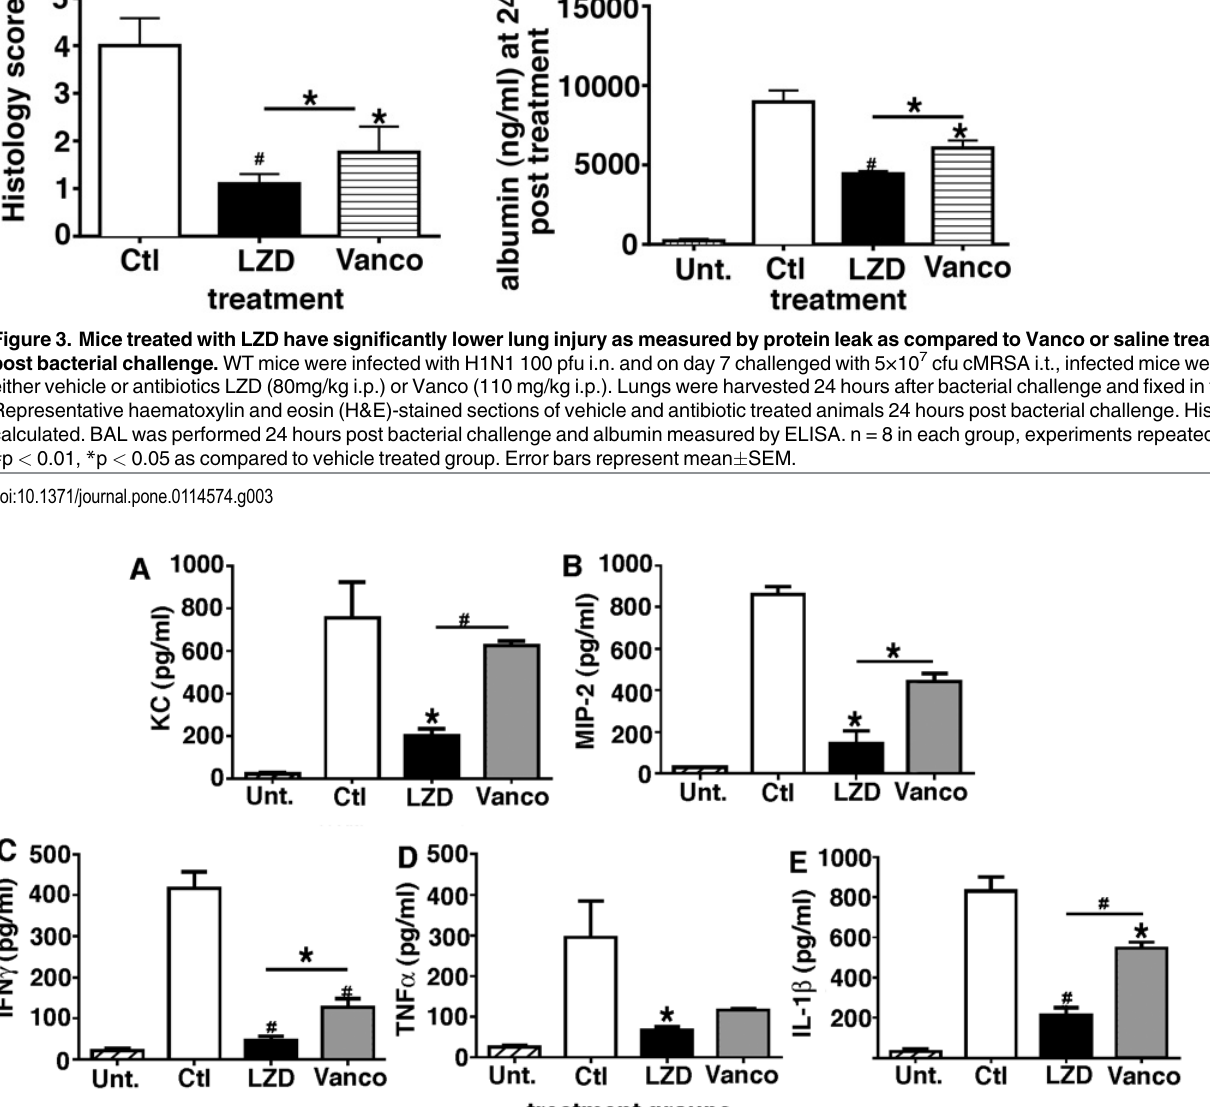
PLOS ONE | DOI:10.1371/journal.pone.0114574 January 30,